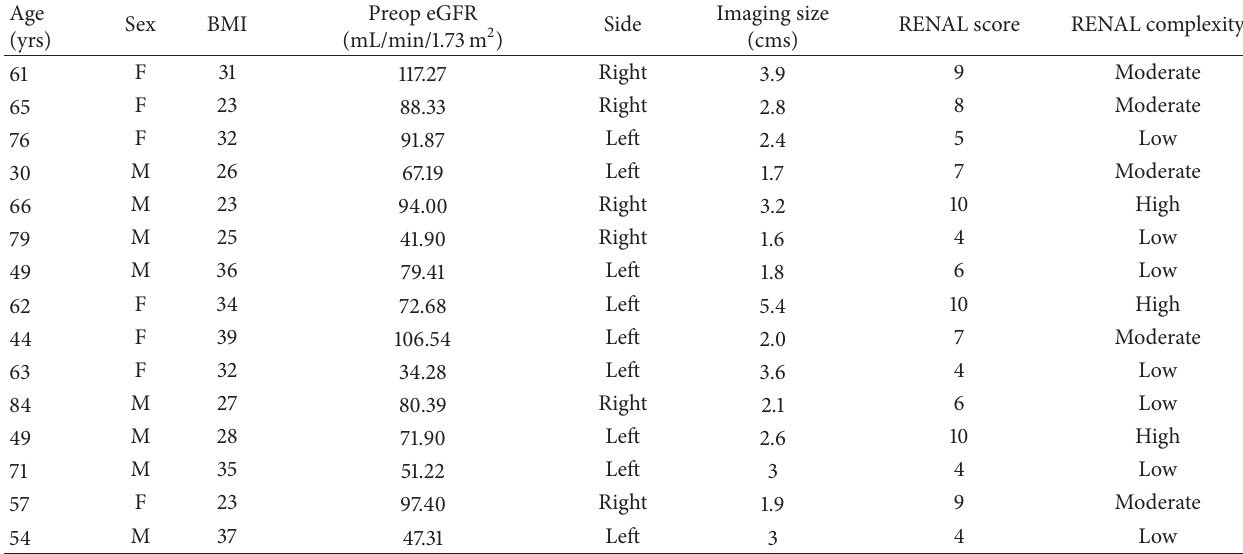
Table 1: Demographic and preoperative characteristics.